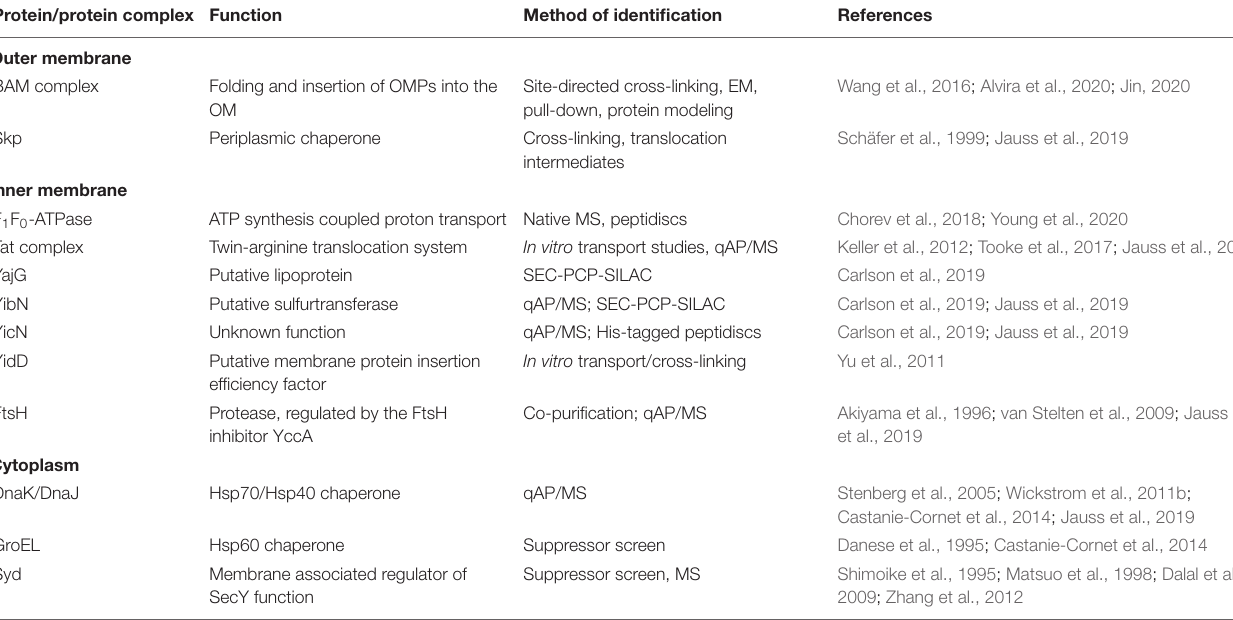
TABLE 1 | Interaction partners of the SecYEG translocon. Protein/protein complex